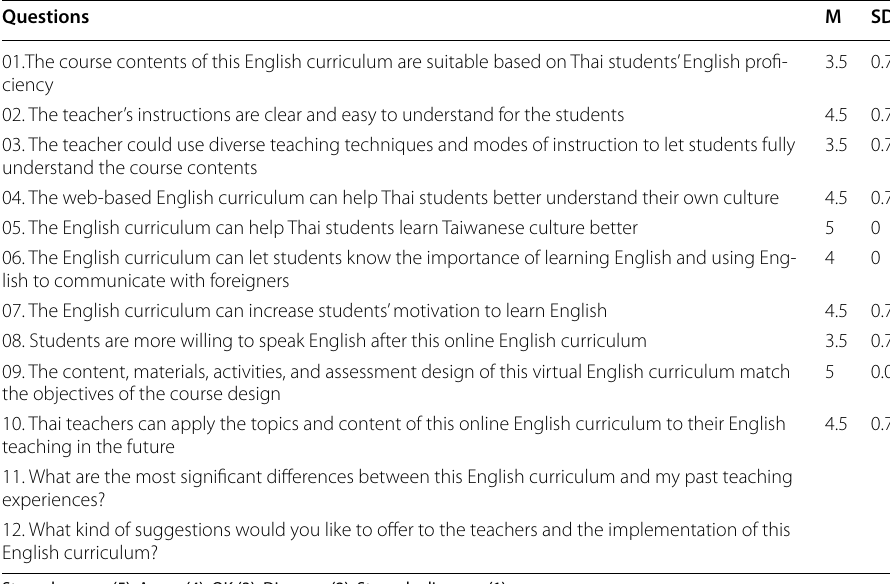
Strongly agree (5); Agree (4); OK (3); Disagree (2); Strongly disagree (1)